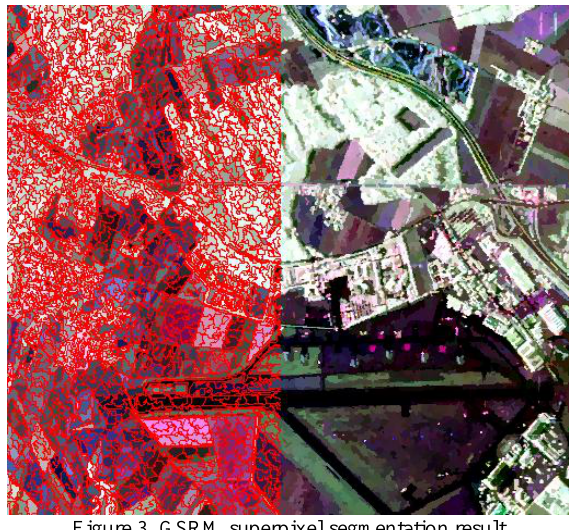
Figure 3. GSRM superpixel segmentation result